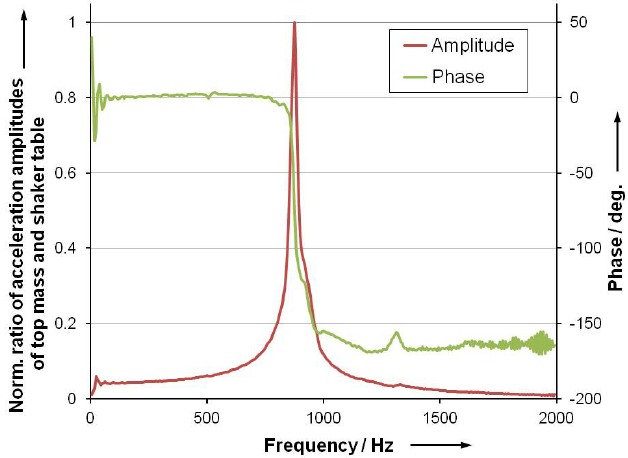
Fig. 5. Measured resonance behaviour of a piezoelectric force transducer with a top mass of 6 kg.